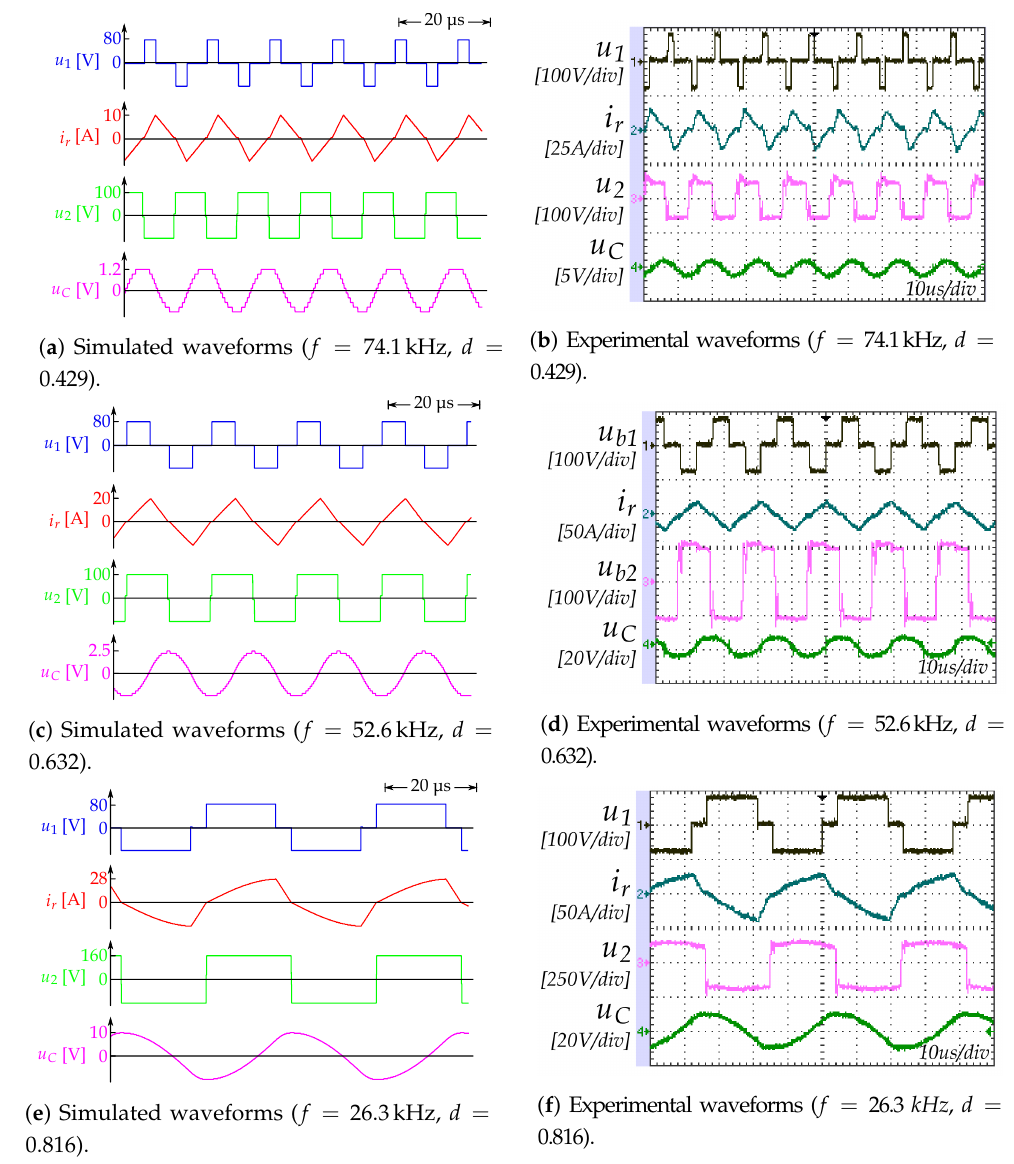
Figure 14. Proposed Converter with Variable Frequency Modulation (VFM) waveforms. ( a , b ) U 1 = 80V, U 2 = 50V, I OUT = 2.5A. ( c , d ) U 1 = 80V, U 2 = 100V, I OUT = 5A. ( e , f ) U 1 = 80V, U 2 = 160V, I OUT = 9A.